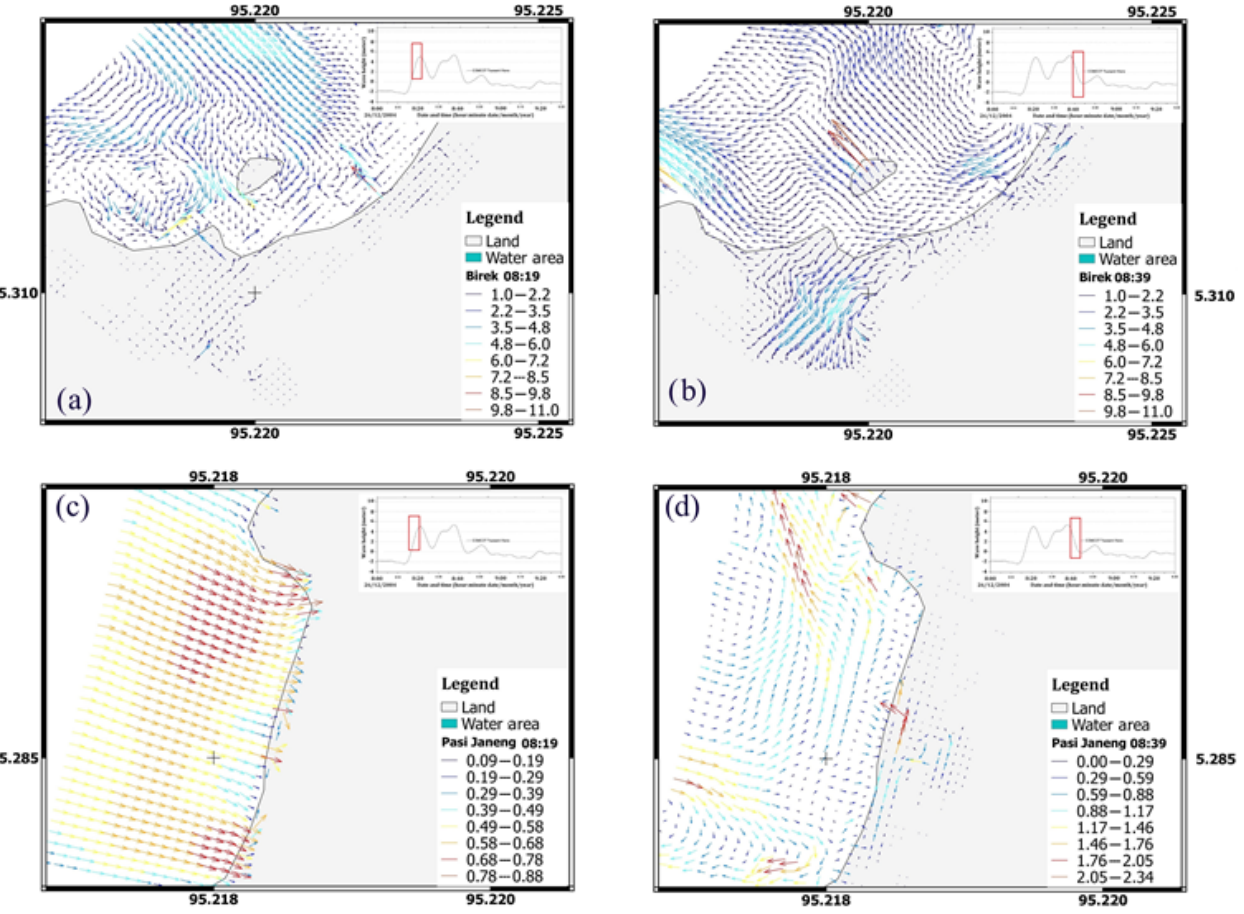
Figure 9. Tsunami wave velocity fields at Birek during wave advance (a) and during wave retreat (b) and at Pasie Janeng during wave advance (c) and during wave retreat (d)